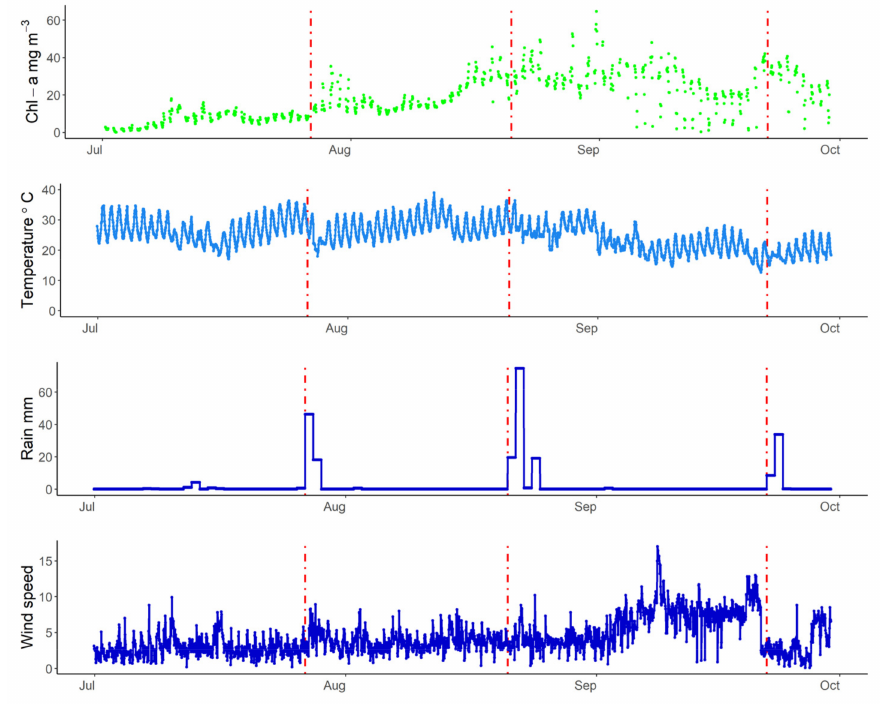
Figure 7. Lake Trasimeno Chl-a (hourly), air temperature (hourly), rain (daily total), and wind speed (hourly) between July and September 2019. Dashed red lines indicate 27 July, 21 August, and 22 September 2019.